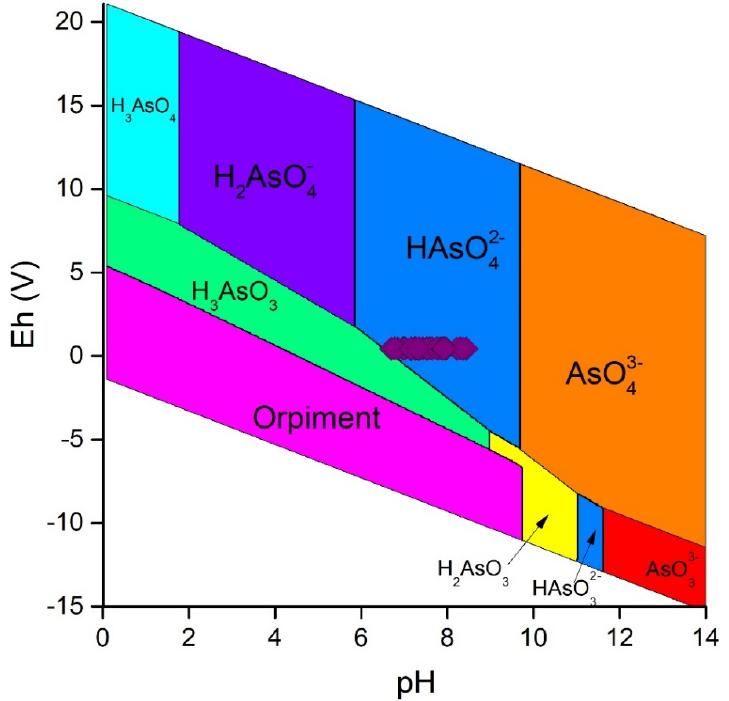
Figure 6. Eh–pH diagram of As–S. Purple diamonds represent the CO 2 -saturated eluates.